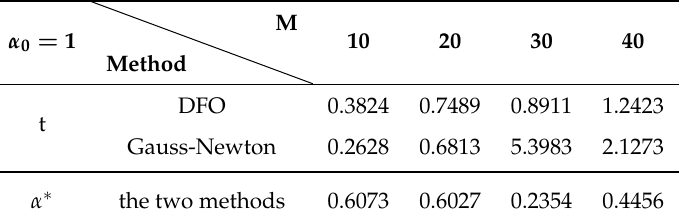
the two methods